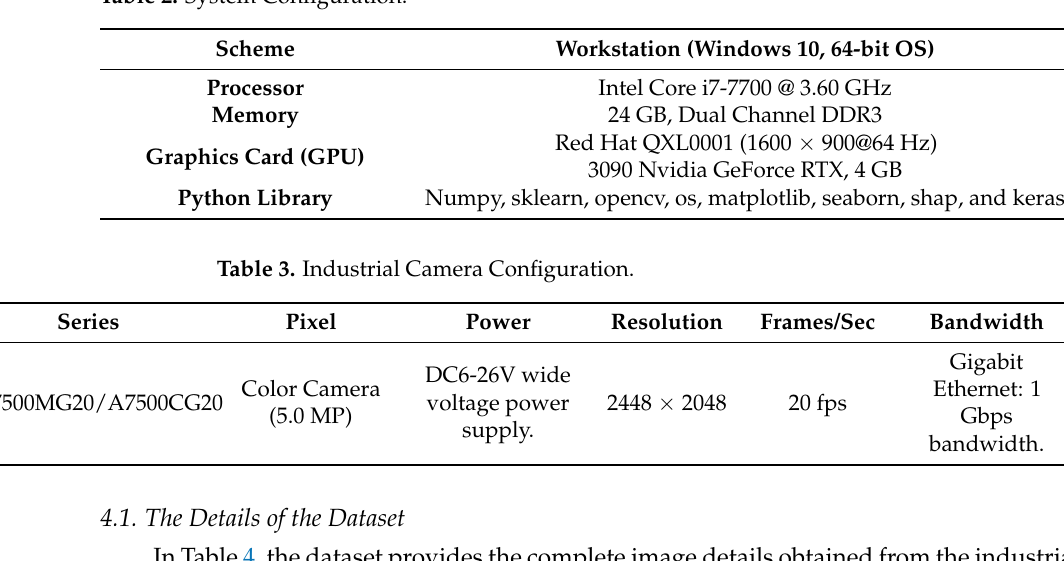
Table 2. System Configuration.